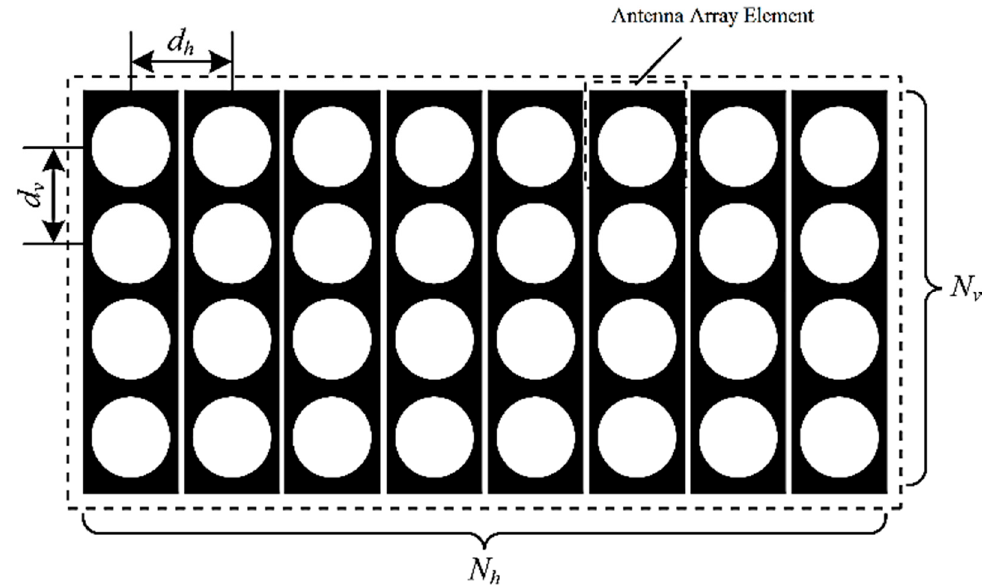
Figure 4. 3D-MIMO uniform planar array (UPA) antenna array configuration.